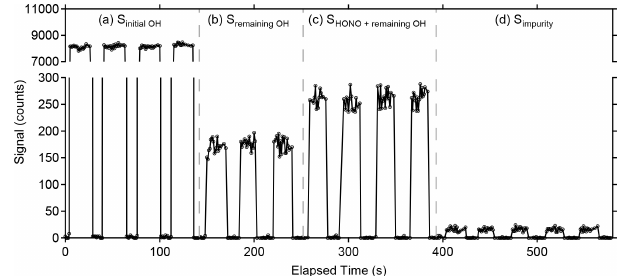
Figure 6. Example of photofragmentation efficiency measurements from an OH + NO → HONO calibration. (a) The signal observed from total amount of OH produced in the calibrator ( S initial OH ). (b) Signal observed from remaining OH after the addition of NO converts the majority of radicals to HONO ( S remaining OH ). (c) Sum of signal from remaining OH and signal from OH produced in the detection cell after HONO photolysis ( S HONO + remaining OH ). (d) Signal from the 355nm photolysis of impurities in the NO cylin- der observed when the radical source in the calibrator is turned off ( S impurity